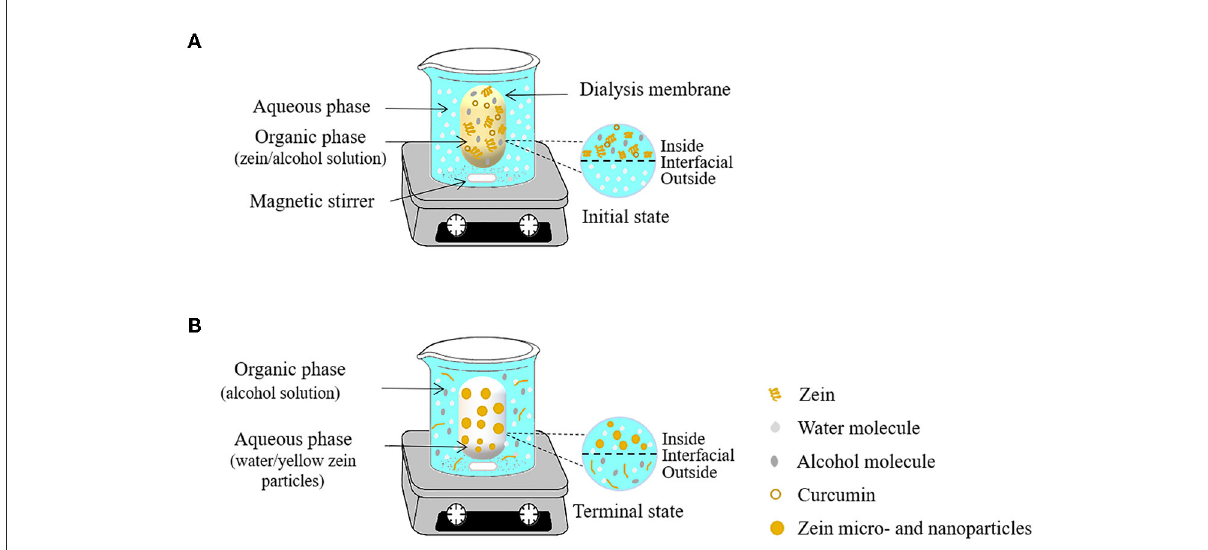
FIGURE4 Schematic representation of antisolvent dialysis method for the obtaining of zein micro- and nanoparticles. At time 0h (A) and after 12h of the process (B)